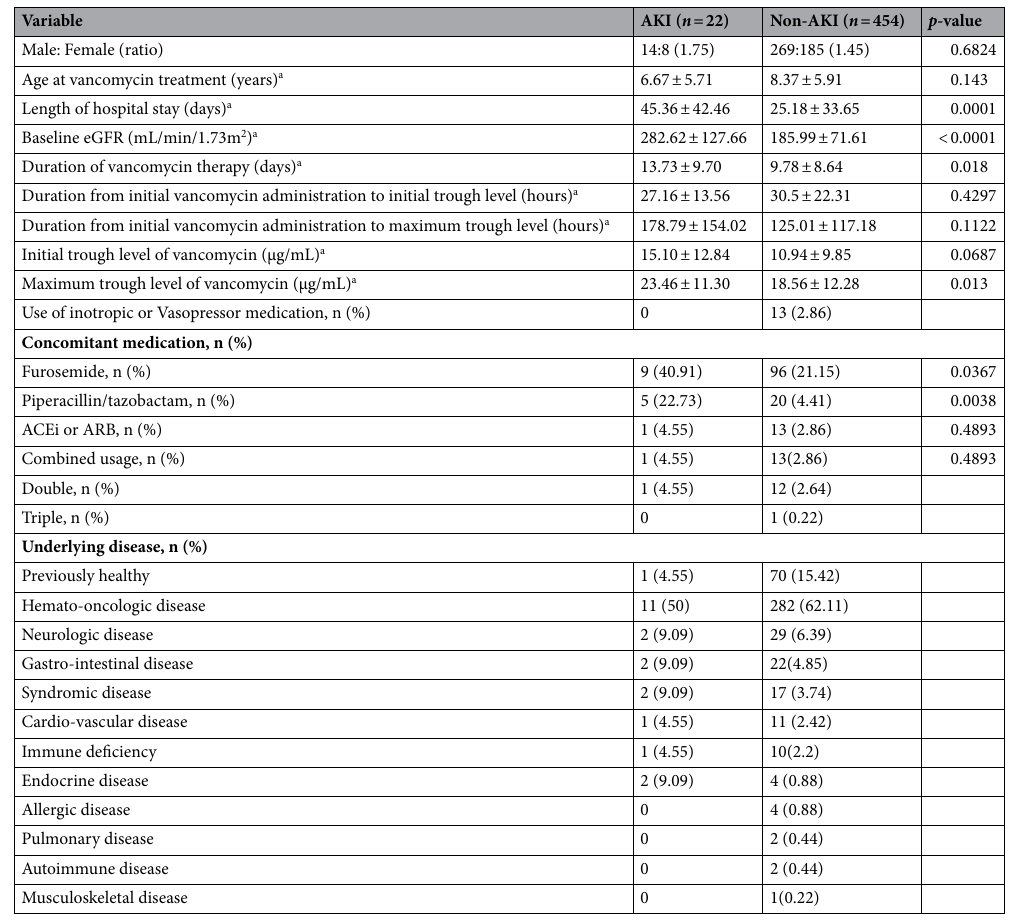
Table 2. Clinical characteristics of patients with and without VIN. a Data are presented as the mean with